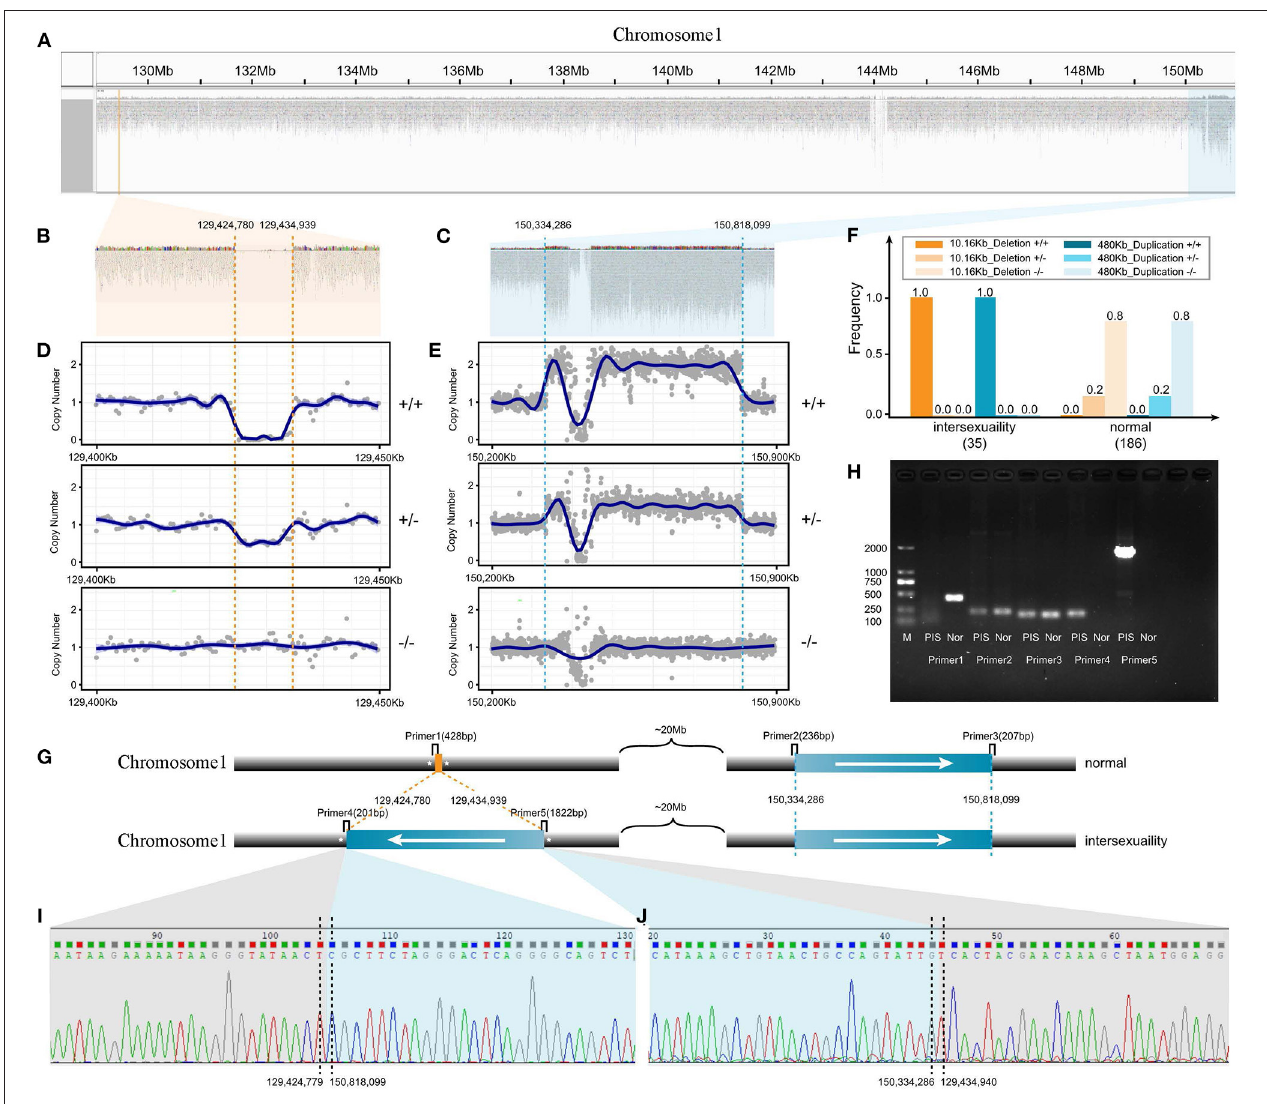
FIGURE 2 | Model detection and verification of novel transposition in intersex goats. (A) Two CNVs (V1 and V2) on Chromosome1 observed by IGV software. (B) Alignment and coverage of wide-genome short-reads from intersex goats as observed with IGV software. The CNV from 129,424,780 to 129,434,939 bp on Chromosome 1 (V1, B ) manifested as a deletion. (C) Alignment and coverage of wide-genome short-reads from intersex goats as observed by IGV software. The CNV from 150,334,286 to 150,818,099 bp on Chromosome 1 manifested as a duplication (V2). (D) Genomic coverage of different genotypes of V1 variant